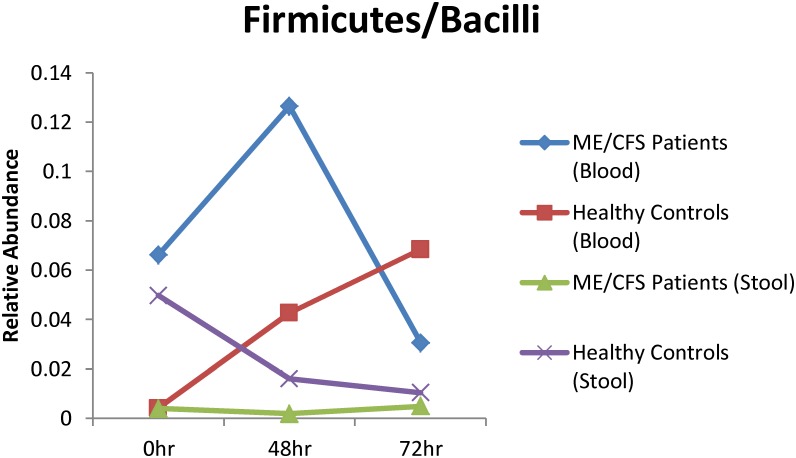
Changes in the relative abundance of Firmicutes/Bacilli in blood and stool samples before (0 hr) and after maximal exercise.